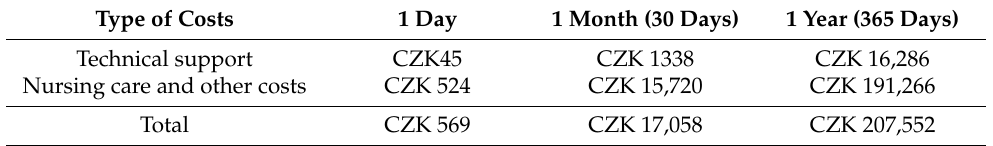
Table 2. The overall average costs per patient with the non-invasive home mechanical ventilation